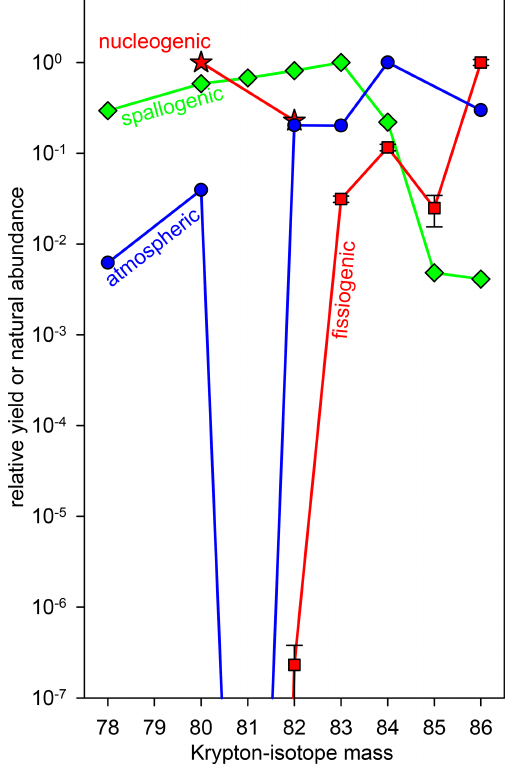
Figure 1. Relative abundances of krypton isotopes in natural sources of krypton. Normalized krypton abundances (normalized to the most abundant isotope of a given source) of atmospheric (Aregbe et al., 1996; Sturchio et al., 2004), fissiogenic (from sponta- neous fission of 238 U; JAEA, 2011), nucleogenic (thermal neutron capture by bromine; Soppera et al., 2014; Kendrick, 2012) and spal- logenic (proton-irradiation experiments, zirconium, ≥ 49gcm − 2 shielding; Table 2a of Gilabert et al., 2002) krypton. Most geolog- ical material on Earth contains atmospheric krypton, with all large geochemical reservoirs (i.e. mantle, crust) containing krypton of at- mospheric